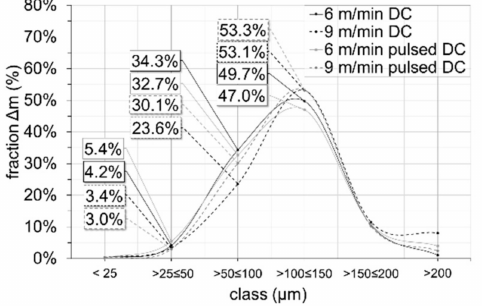
Figure 18. Distribution of the classes as a function of the current form and the wire feed speed.